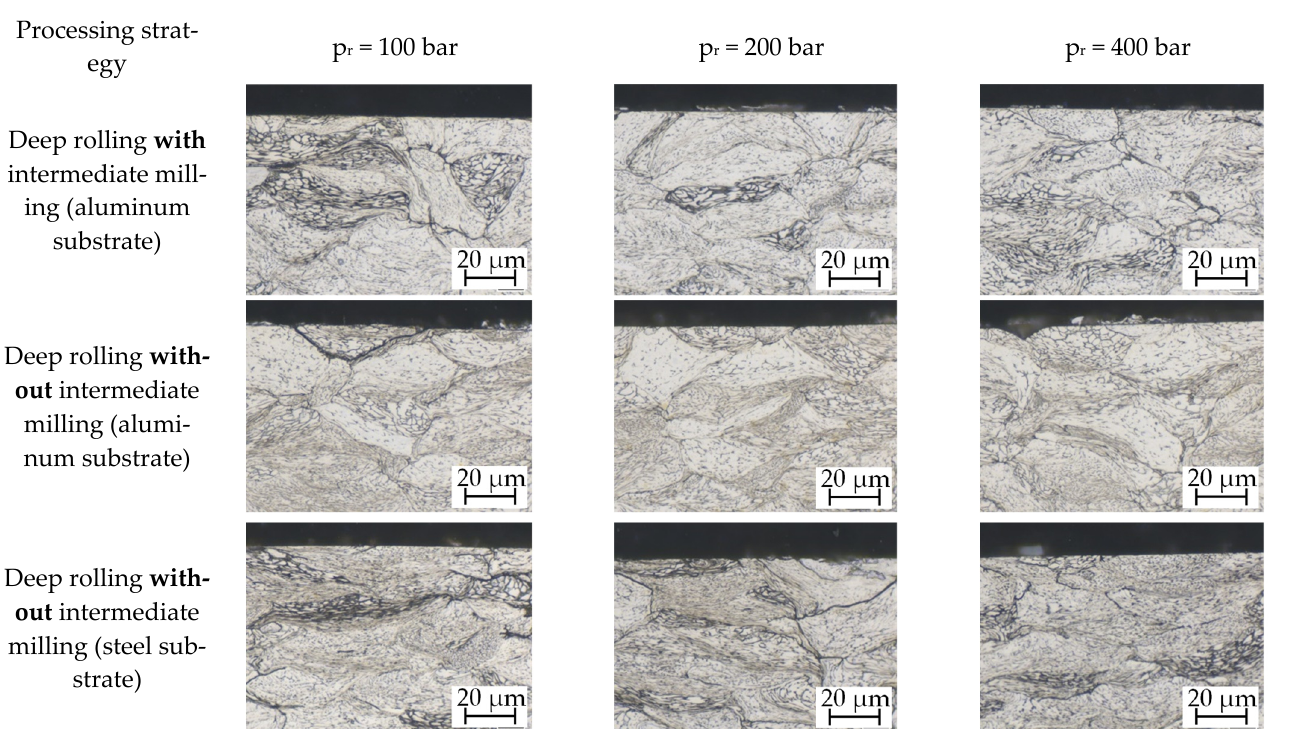
Figure 10. Influence of increasing deep rolling pressure with and without intermediate milling on both substrate materials for 316L (etched 20 s in 60% electrolytic HNO 3 (1.5 V)).